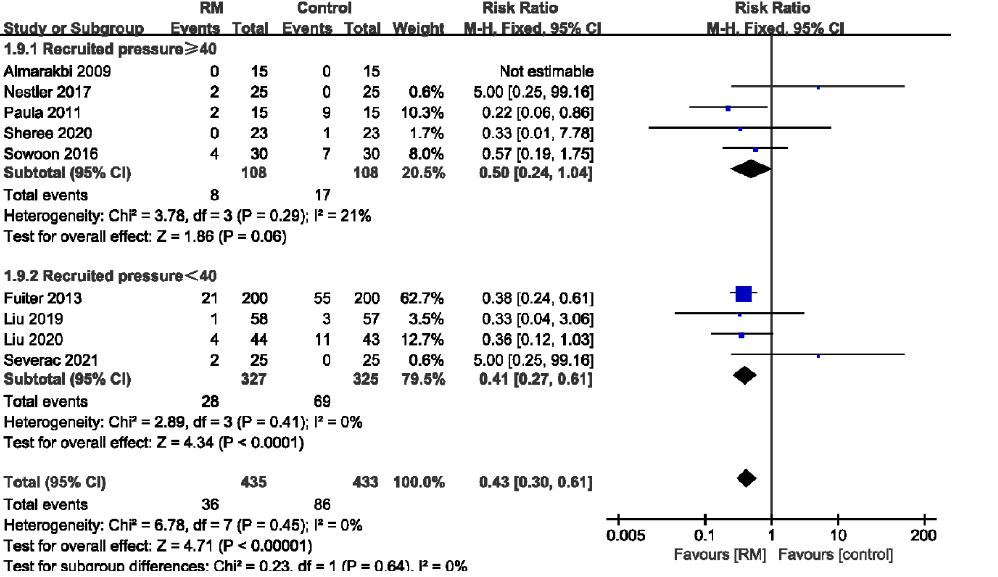
Figure 8. Forest plot for subgroup analysis of the incidence of PPCs between RM and control groups. Grouped by recruited pressure: recruited pressure ≥ 40 cm H 2 O, recruited pressure < 40 cm